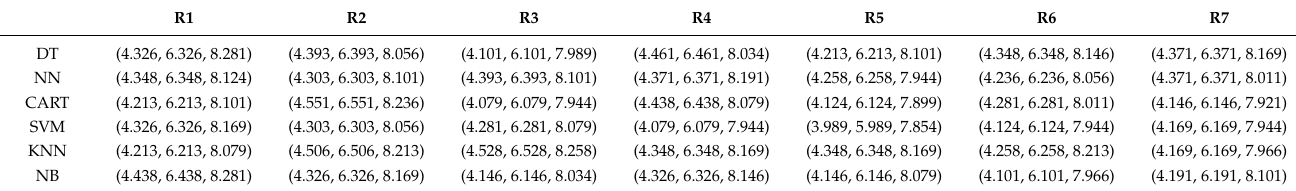
Figure 4. Range from positive as well as negative ideal alternative solutions. Table 4. Fuzzy-based Decision Matrix.